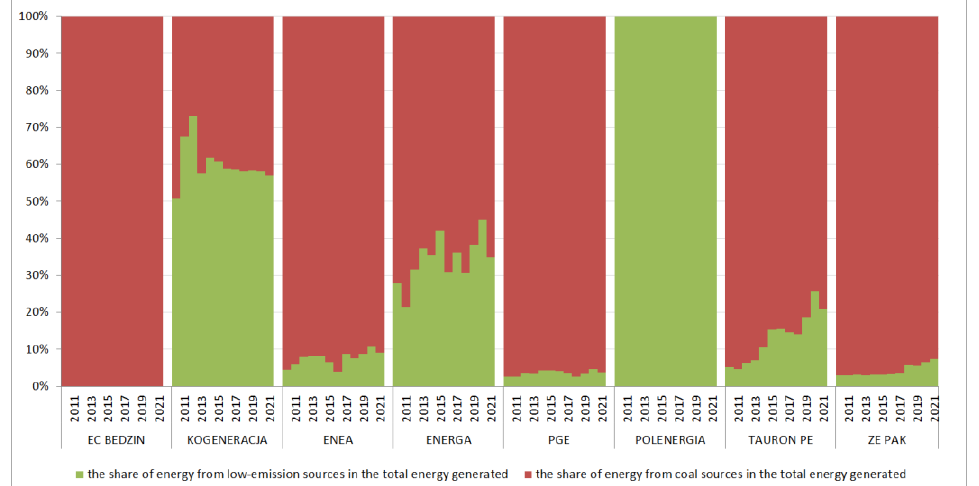
Figure 2. The structure of electricity generation in the surveyed power companies by low-carbon and carbon-fired sources. Source: own elaboration.